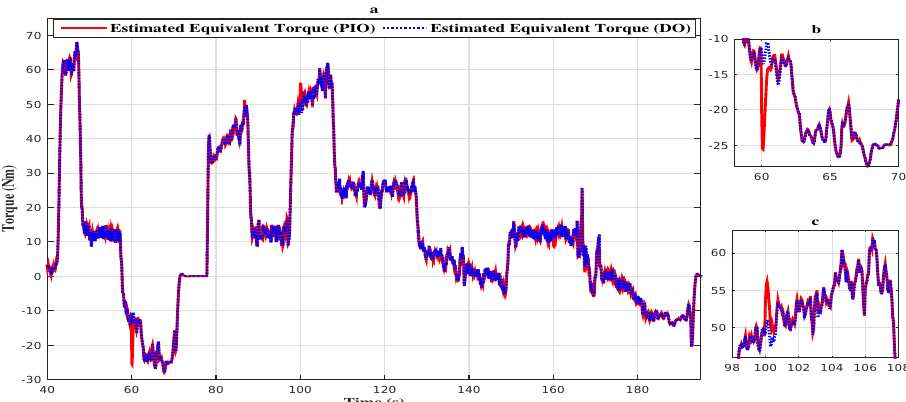
Figure 11. ( a ) Comparison of the vehicle estimated torque with the two observers. ( b ) Zoom in at t ∈ [ 58 s,70 s ] . ( c ) Zoom in at t ∈ [ 98 s,108 s ]